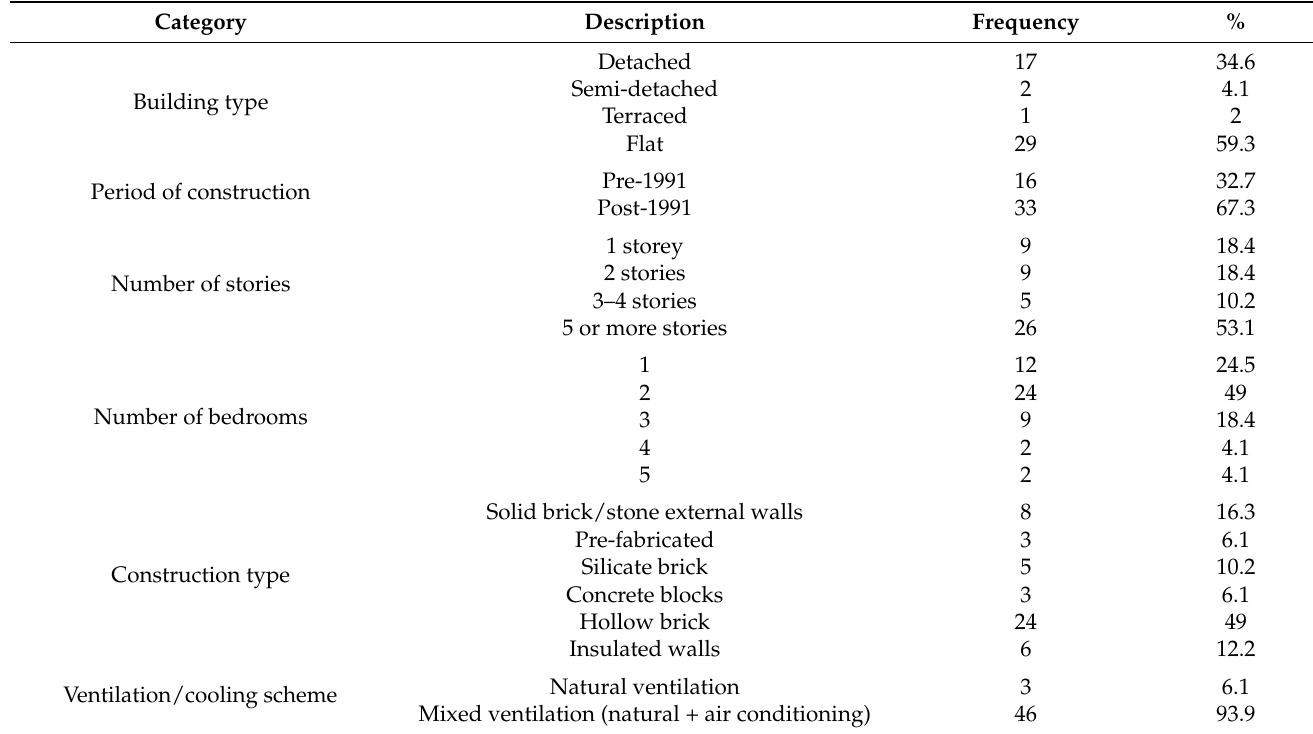
Table 1. Frequency of different characteristics in the